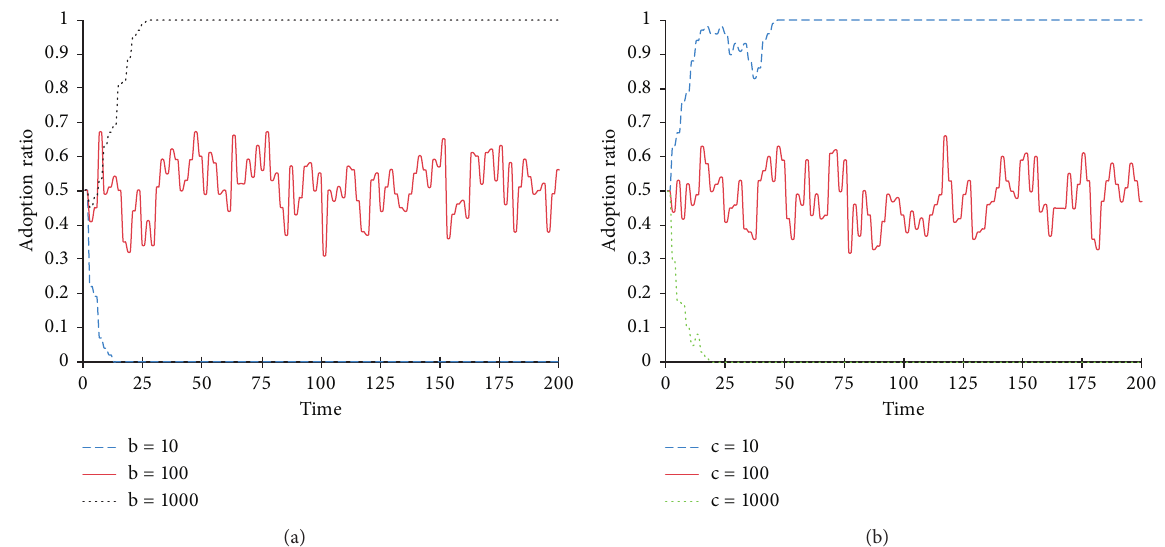
Figure 4: Internal validation indicating simulation model conformance with the conceptual model.